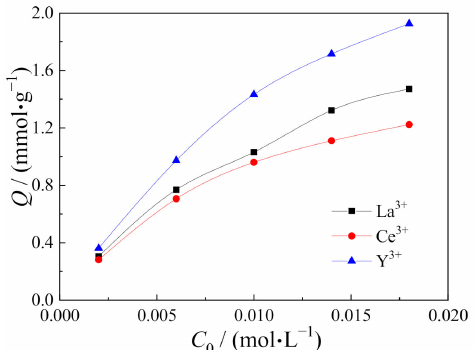
Figure 8. Effect of initial concentration of metal ions on the adsorption capacity of PAMHA (pH for La 3+ , Ce 3+ , and Y 3+ were 1.5, 3.0, and 2.0, respectively, 5 h, 45 ◦